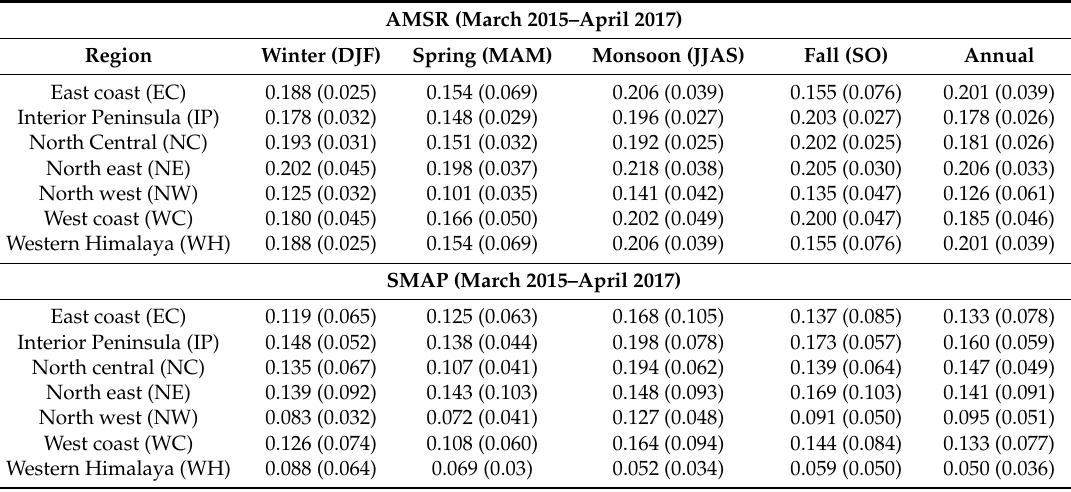
Table 1. Seasonal and annual mean soil moisture (cm 3 /cm 3 ) and their standard deviations observed by AMSR and SMAP datasets over seven homogeneous regions in